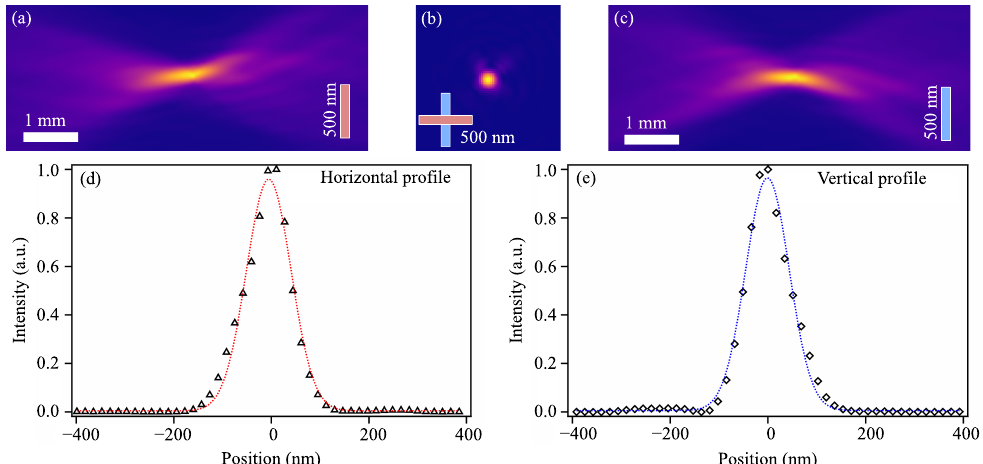
Figure 3. Characterization of the nano-focused X-ray beam by ptychography. ( a ) Beam caustic in the horizontal plane. ( b ) Beam-intensity distribution in the focus plane. ( c ) Beam caustic in the vertical plane. Line profiles through the focus for horizontal (( d ), points) and vertical (( e ), points) plane. The dotted lines are Gaussian fits that yield a FWHM of 108nm for the horizontal plane and 105nm for the vertical